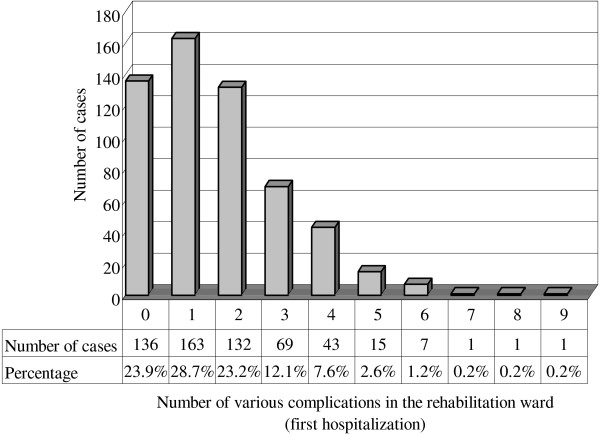
The number of cases and various complications in the rehabilitation ward. The numbers on the X-axis correspond to the following: 0 = the sum of the complication types is zero, 1 = the sum of the complication types is one, and so on. The major numbers of various complications in the rehabilitation ward were 0, 1, 2, and 3, resulting from 23.9%, 28.7%, 23.2%, and 12.1% of total patients, respectively.